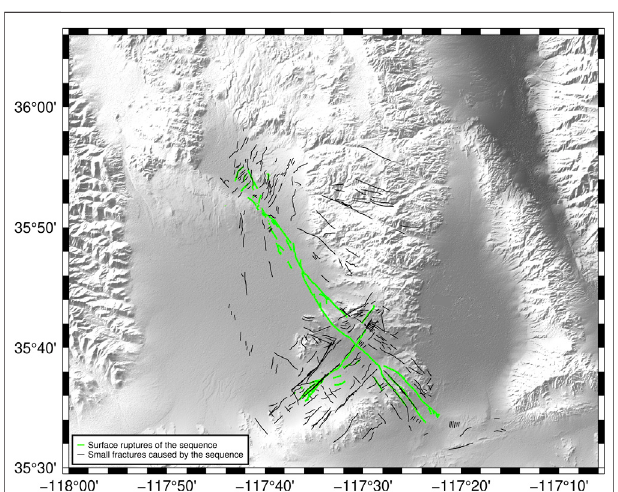
FIGURE 2 | Distribution of small fractures in the Ridgecrest region after the earthquake sequence. Green lines show the surface ruptures (Brandenberg et al., 2019), and black lines represent the small fractures mapped on phase gradient maps facilitated also by coseismic interferograms and pixel